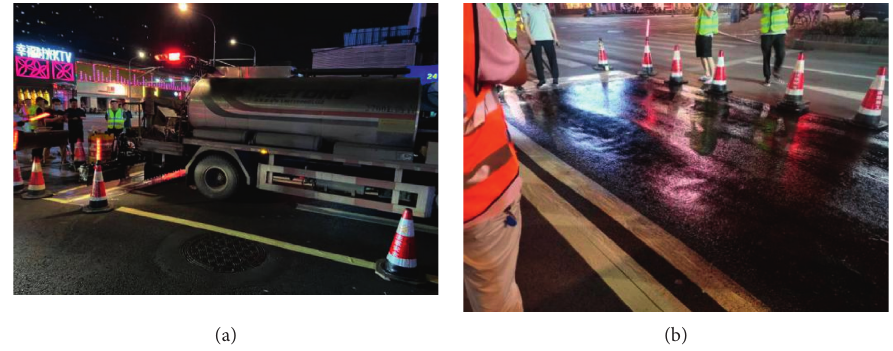
Figure 4: Construction field of fog sealing. (a) Fog sealing truck. (b) Postconstruction site.